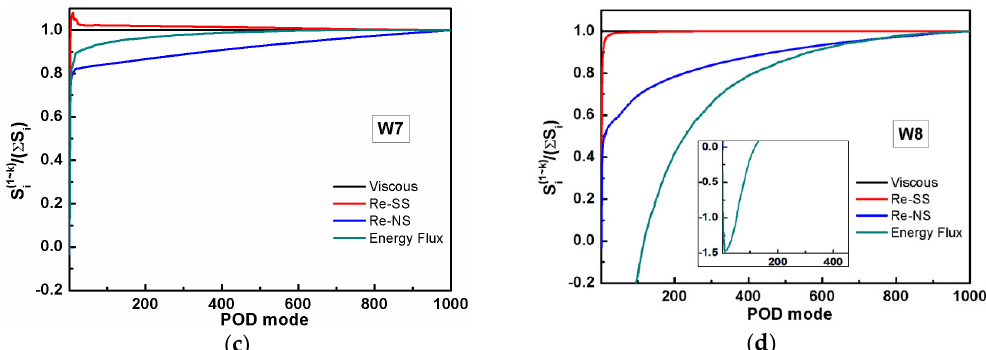
Figure 17. Cumulative contribution to the total integral entropy generation of each POD mode: ( a ) W5; ( b ) W6; ( c ) W7; and ( d ) W8.